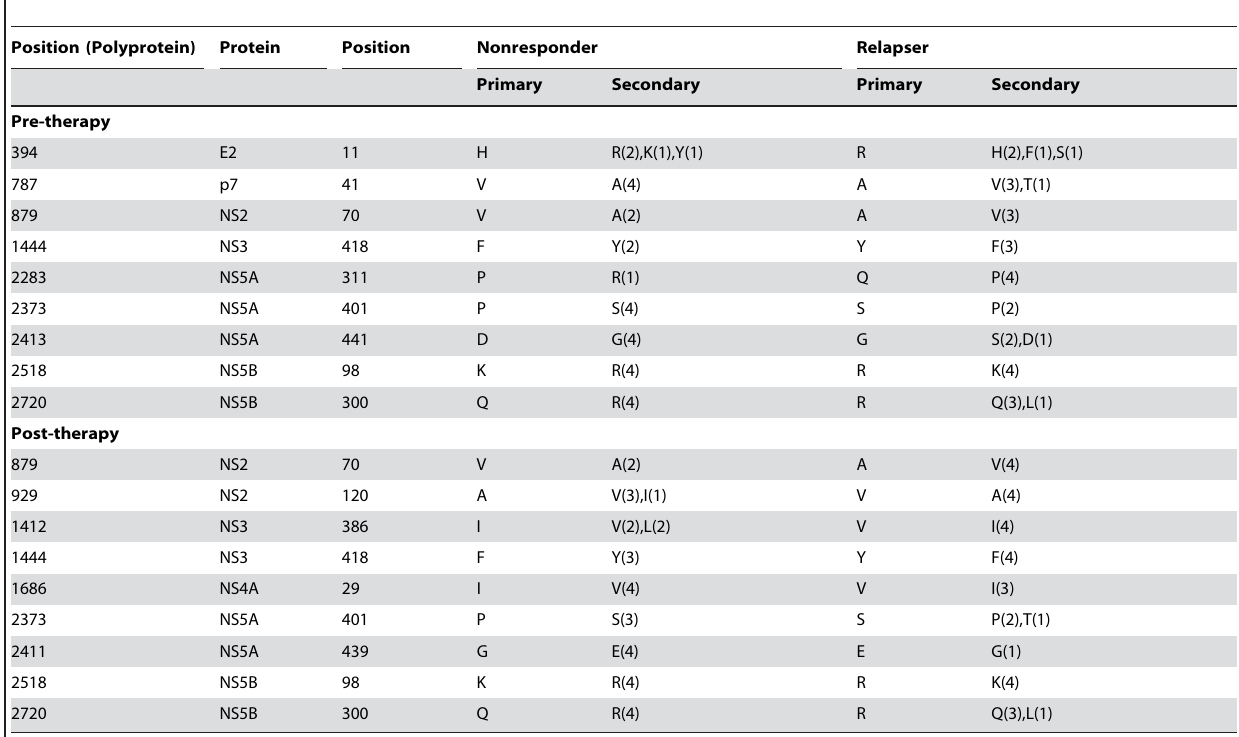
Numbers in parentheses indicate the frequency of the secondary amino acids in the ten sequences. doi:10.1371/journal.pone.0002123.t002 PLoS ONE |